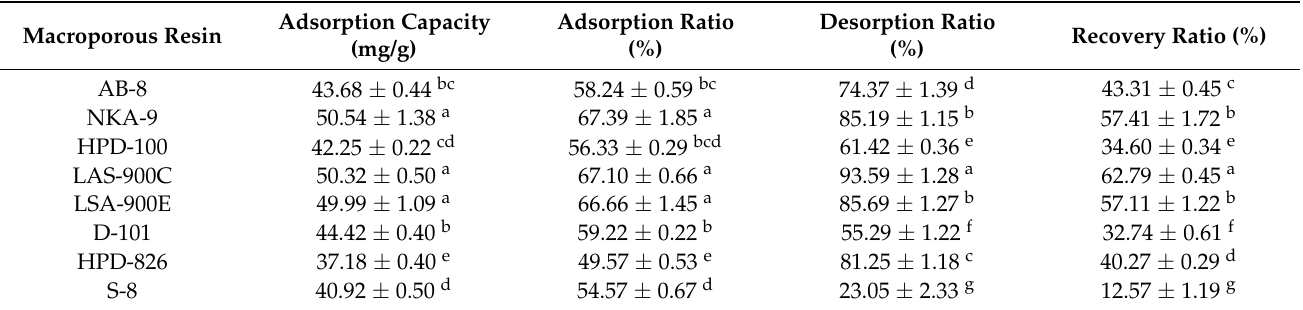
Table 3. Adsorption and desorption performance of different macroporous resins for monoterpene glycosides from P. suffruticosa .